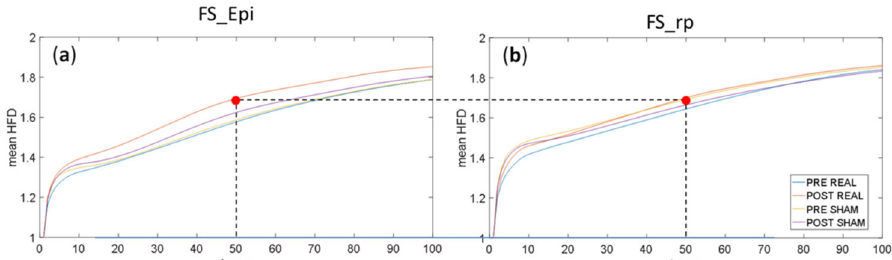
Figure 5. Dependence of average HFD in function of parameter k max in four conditions: PRE REAL, POST REAL, PRE SHAM and POST SHAM calculated for: ( a ) epileptogenic network (FS_Epi) and ( b ) the residual network (FS_rp).